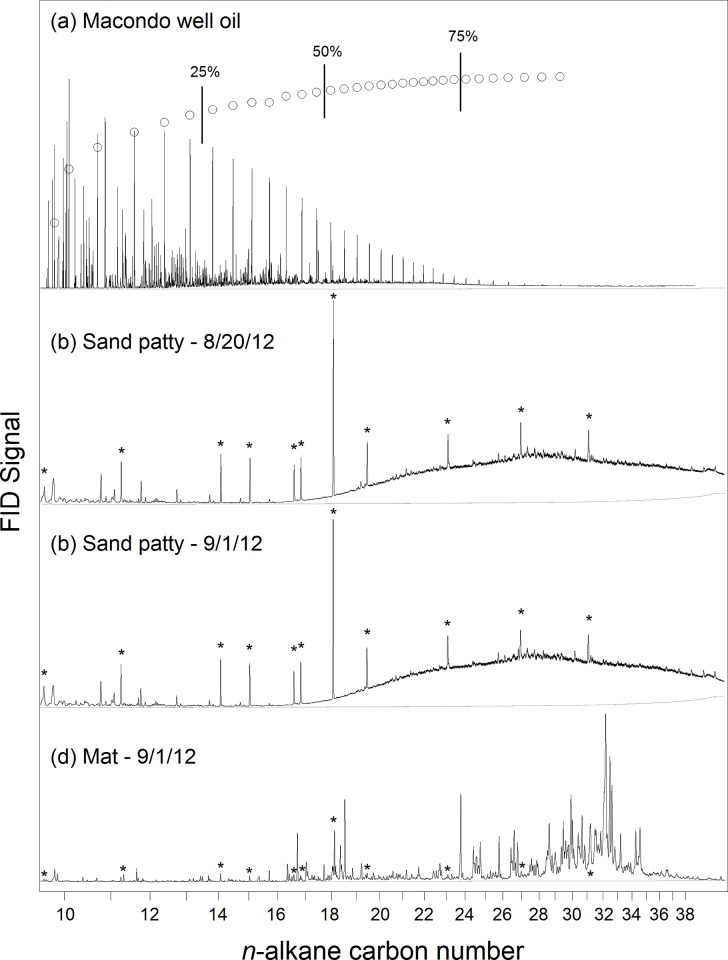
GC-FID chromatograms.Representative gas chromatograms of (a) the neat MW oil, sand patty samples collected (b) before and (c) after Hurricane Isaac and (d) a mat sample collected after the Hurricane Isaac. Simulated distillation data is also shown for the MW oil, with demarcations indicating where 25%, 50% and 75% of the GC-amenable oil mass resides. (Samples shown are the MW oil, 082012–46, 090112–02 and 090112–04 respectively; Table 1). Internal standards are indicated by asterisks (*). The grey line is the baseline of the instrument from the analysis of hexane.